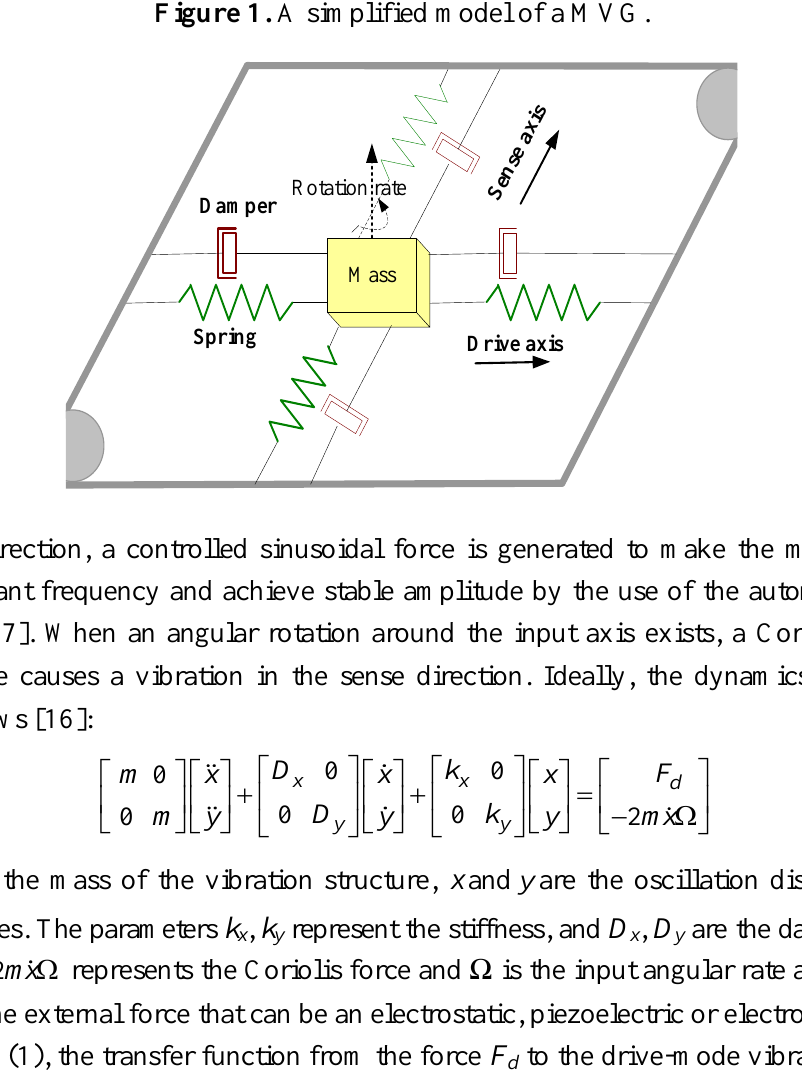
Figure 1. A simplified model of a MVG.